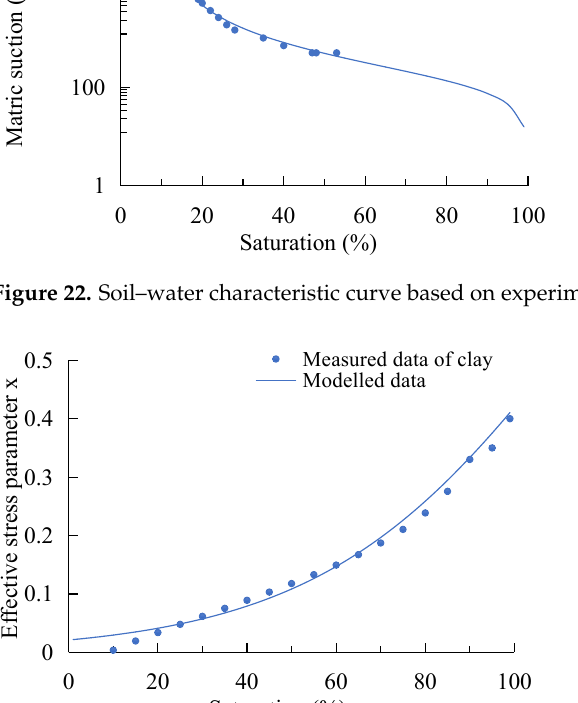
Figure 23. Effective stress parameter